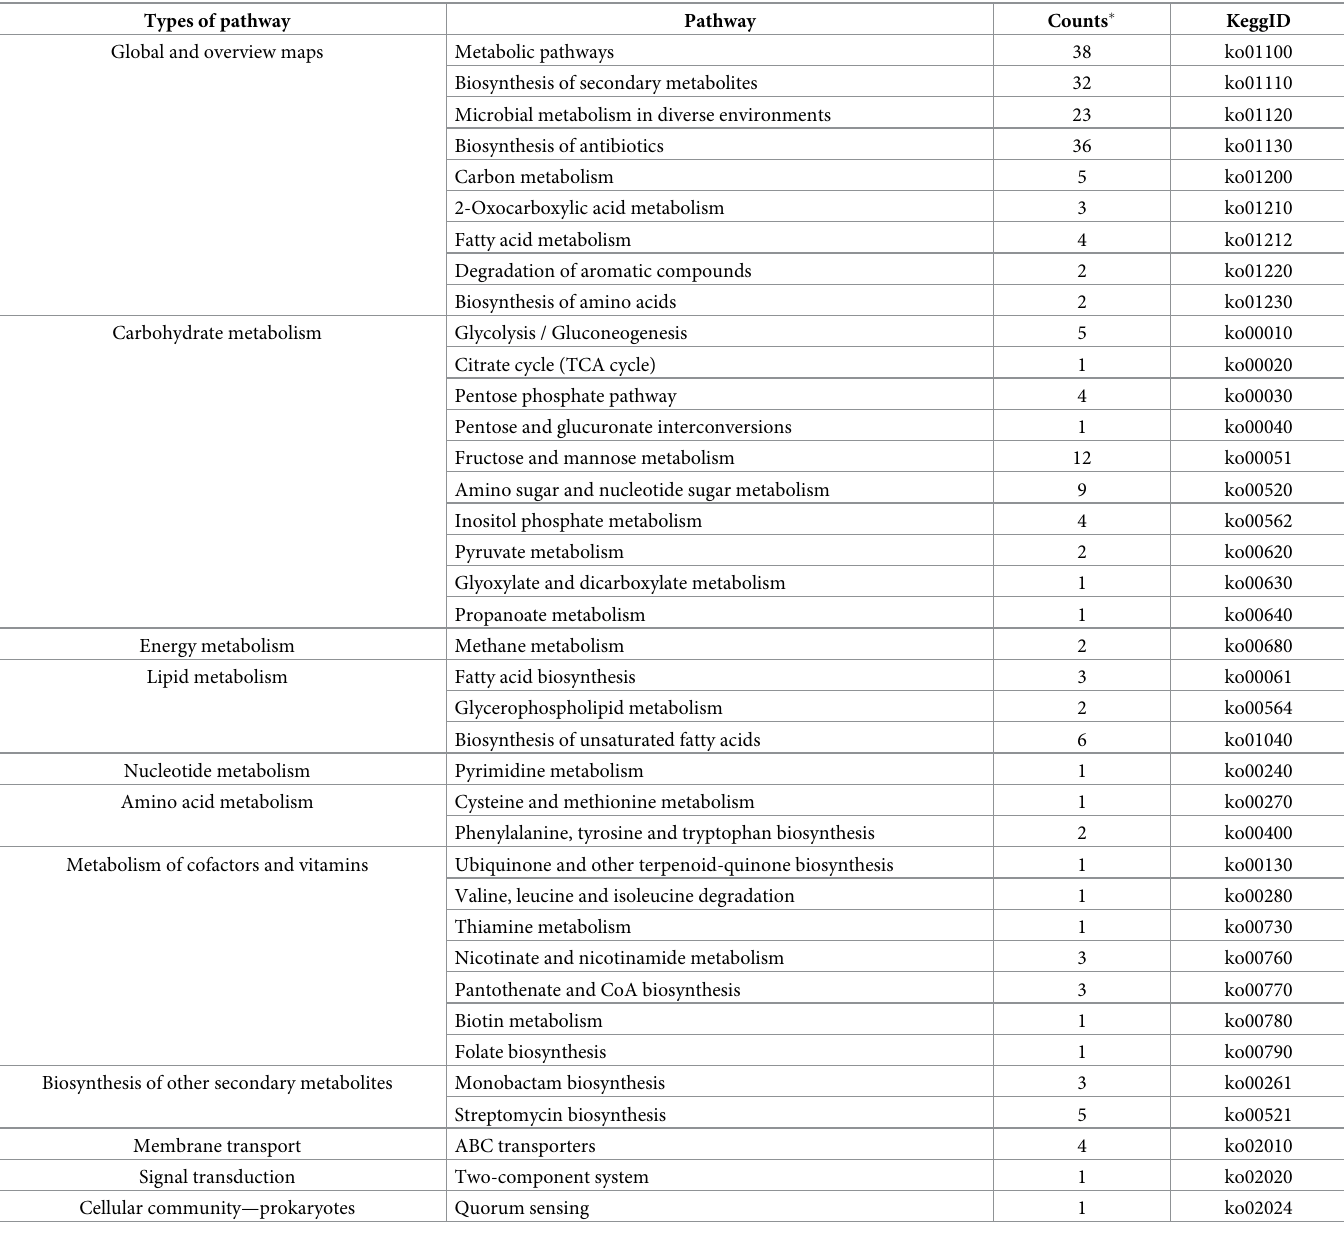
Table 1. Summary of metabolic pathways affected by Wolbachia